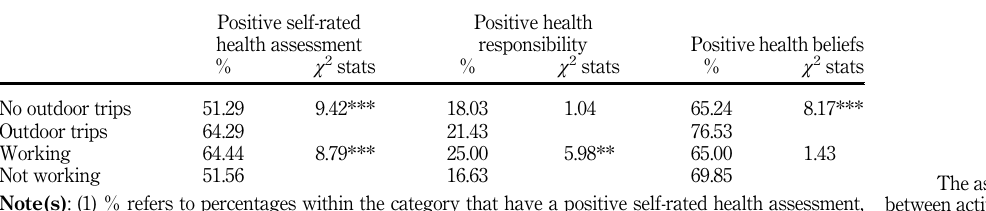
Table 3. The association